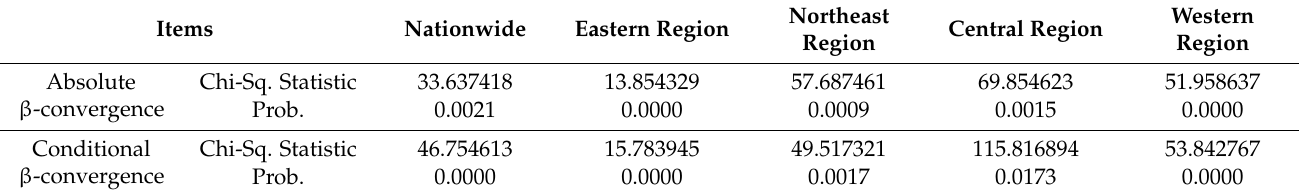
Table 1. The results of the Hausman